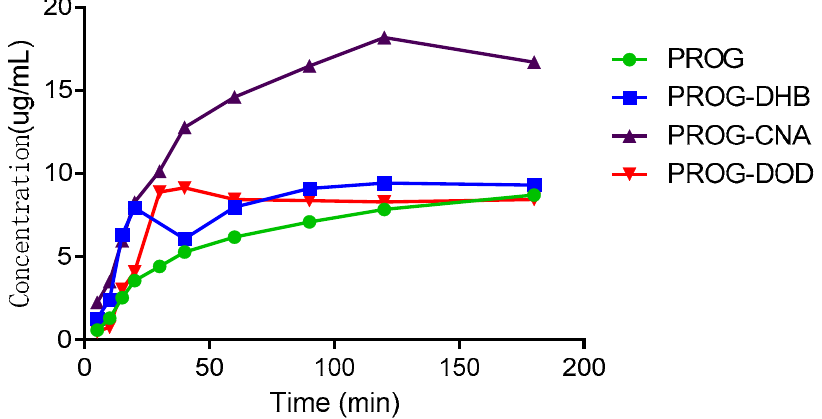
Figure 8. In vitro powder dissolution profile of PROG and the co-crystals at 37 °C .